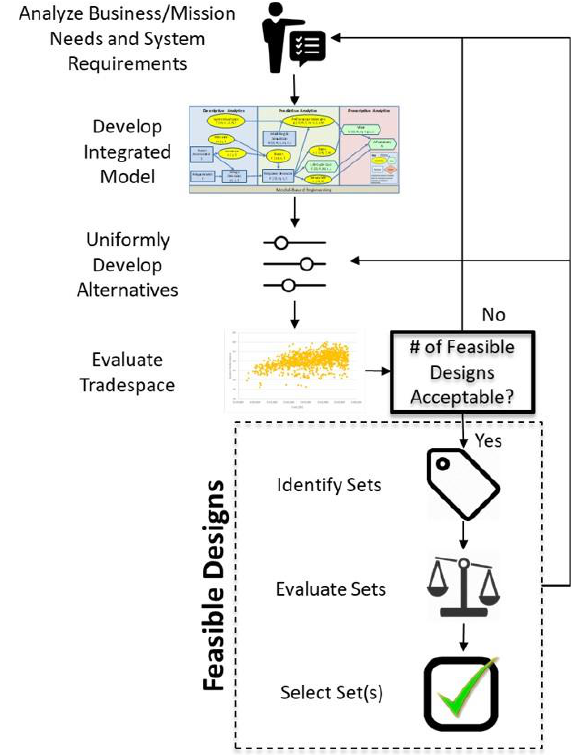
Figure 3. System Analysts SBD Tradespace Exploration Process (Modified from Ref. [39]).